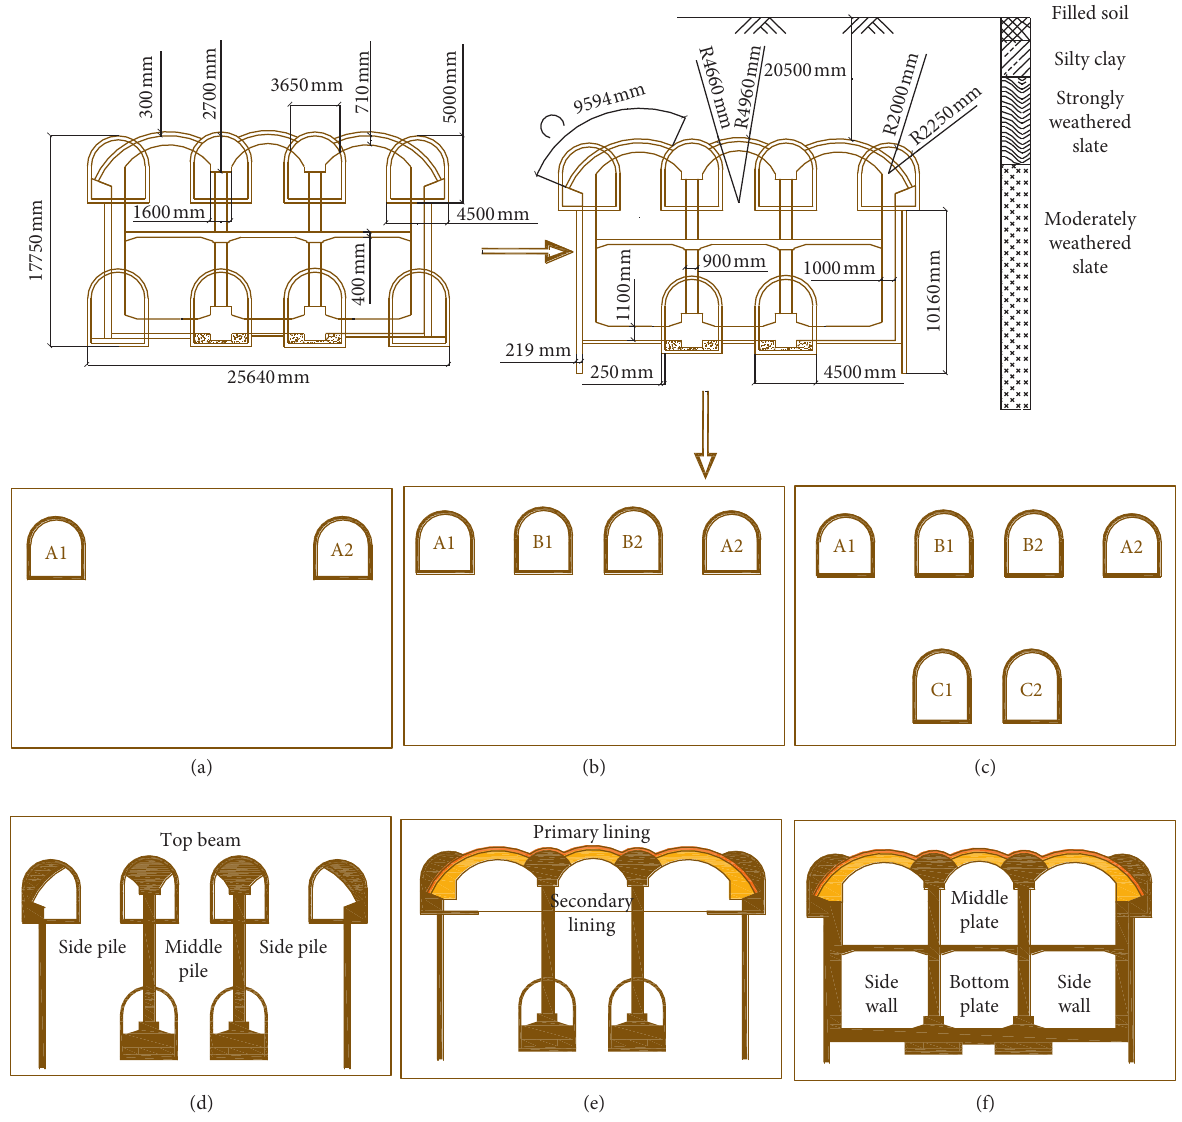
Figure 2: Construction sequence of the PBA